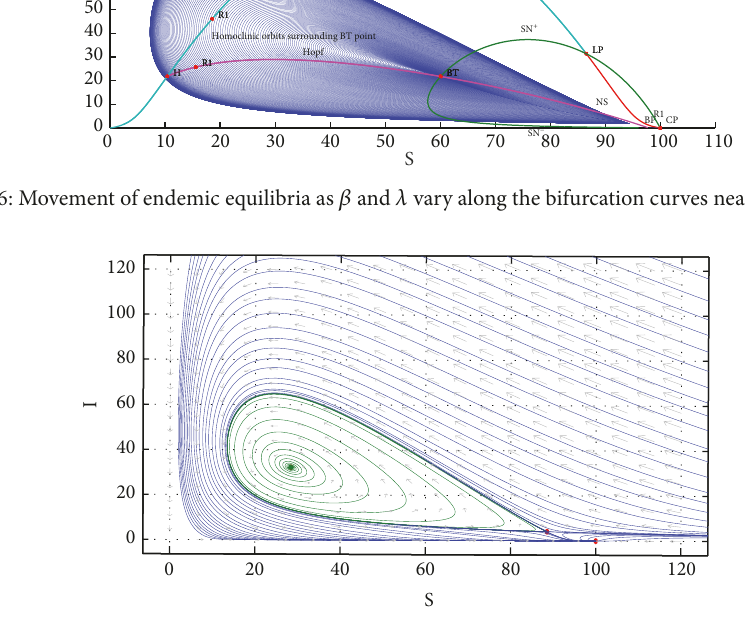
Figure 17: Phase portrait when there are two endemic equilibria: one of them is stable, the other is a saddle point which is connected to itself by a homoclinic orbit. The DFE is a stable node.